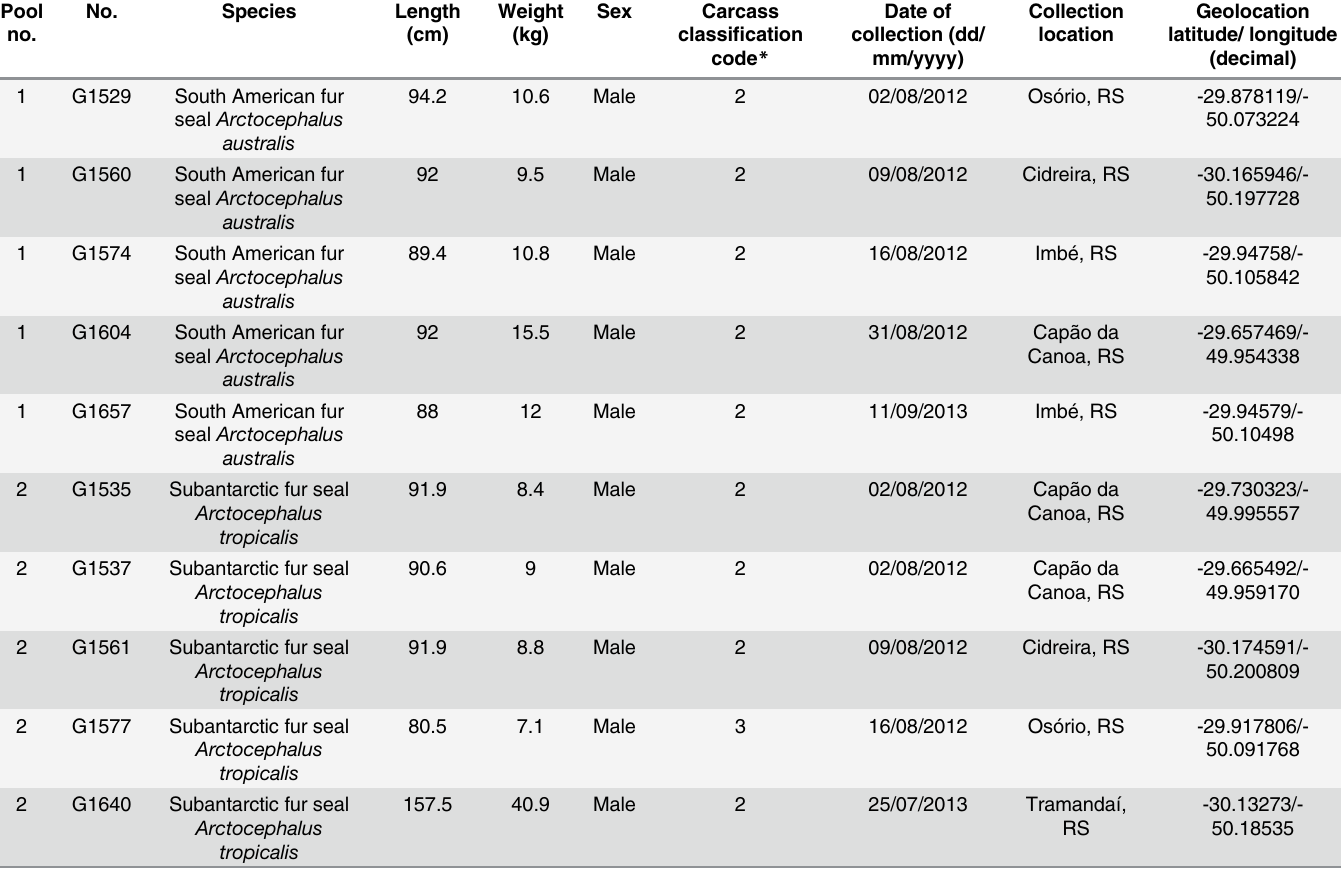
Table 1. Samples used in this study. Pool